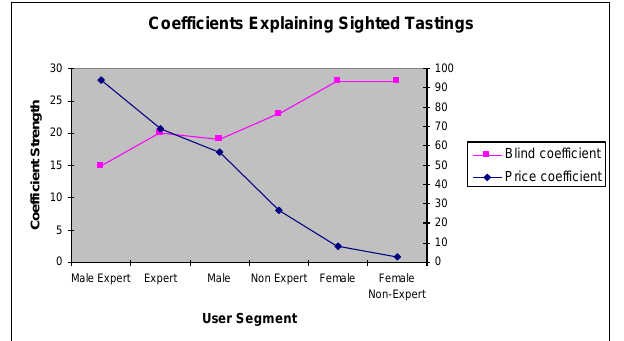
Figure 1: Coefficients explaining sighted tastings across user